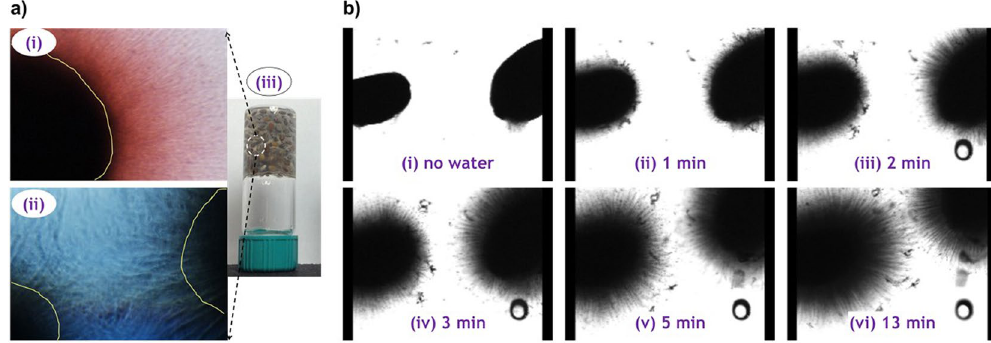
Figure 4. ( a ) Optical micrographs of chia seed fibers dyed with Congo Red (seen as bundle of fibers) and Methylene Blue (seen as interconnected fibers between two seeds), (i) and (ii) respectively; photograph of an inverted chia seed gel (iii); ( b ) Optical microscope video: snapshots of live fiber growth using an optical microscope: (i), no water was added; (ii–vi), number of minutes representing the duration of time elapsed after water was